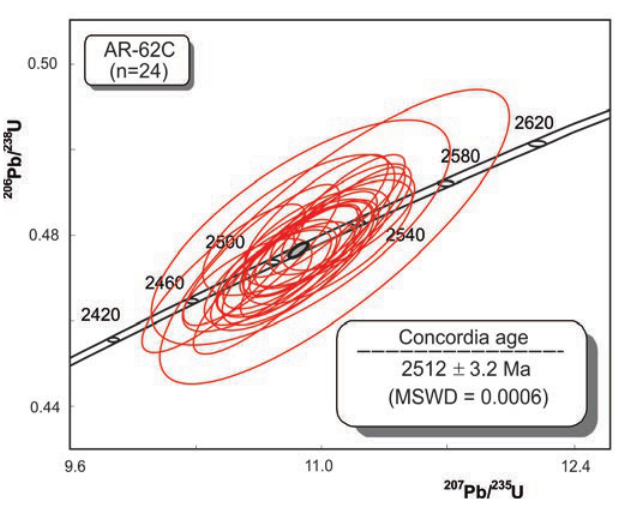
Figure 15 - Concordia diagram for zircons of the microaugen gneiss (sample AR-62C) between 210.3 and 211.3m deep.